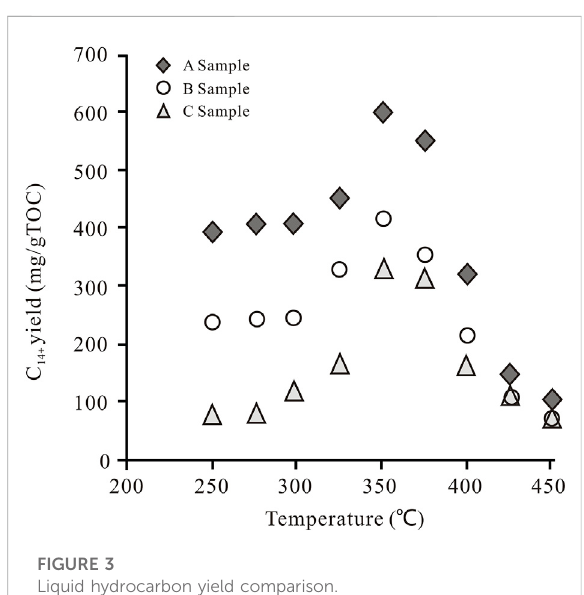
FIGURE 3 Liquid hydrocarbon yield